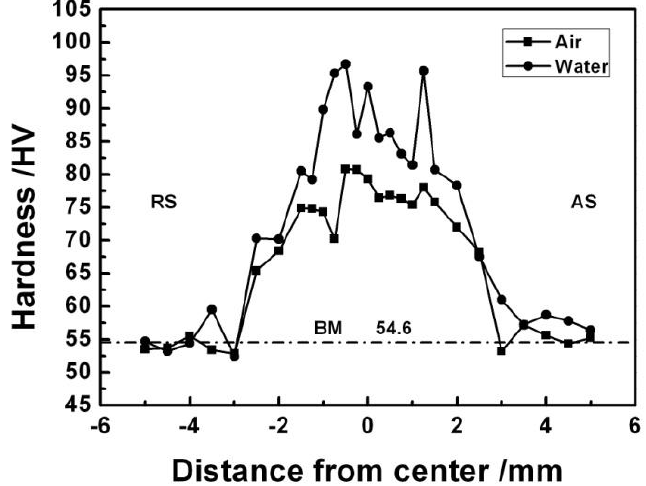
Figure 7. Microhardness distributions of the experimental